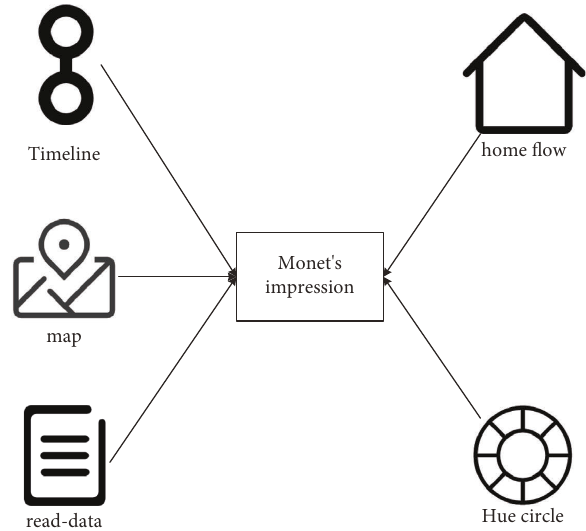
Figure 4: Information architecture